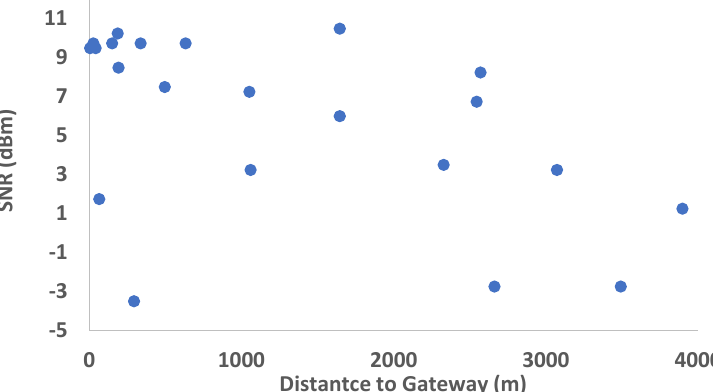
Figure 19. Results of SNR as a function of the distance.